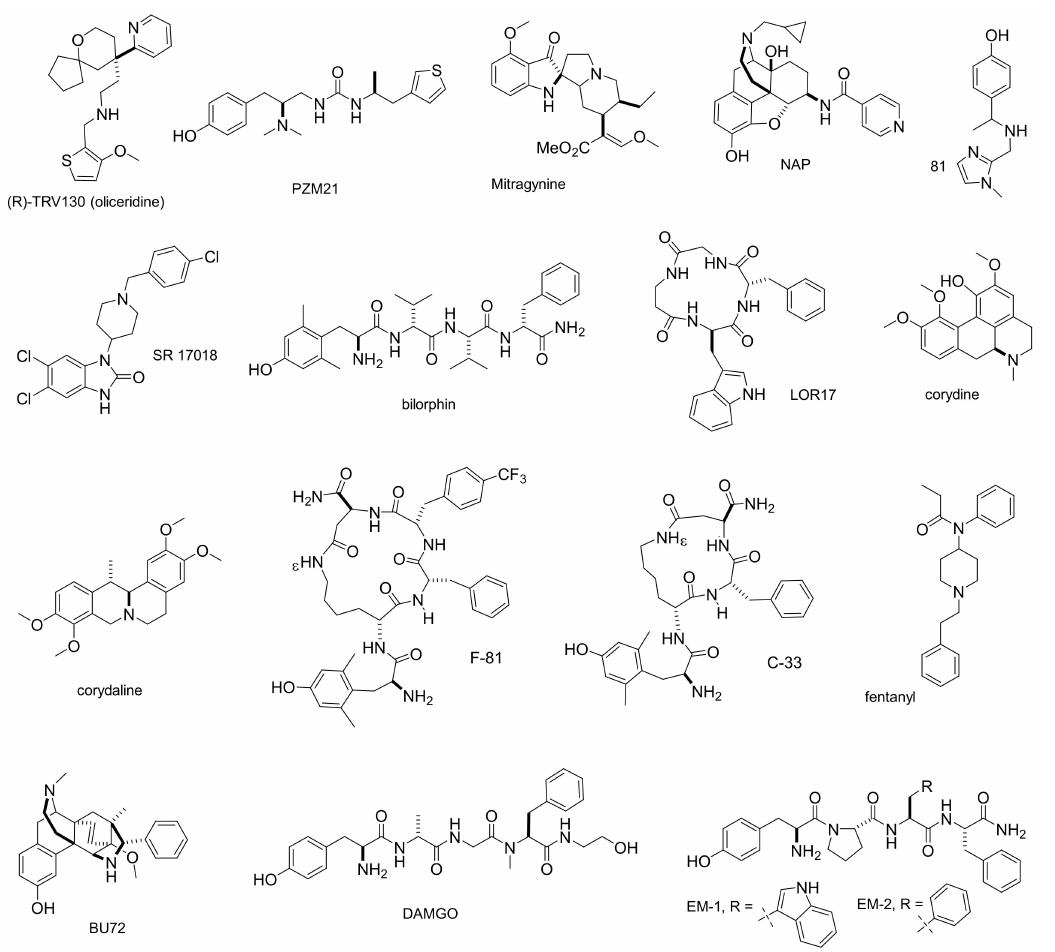
Figure 1. Structures of cyclic peptides F-81 and C-33 and other opioid ligands discussed in this